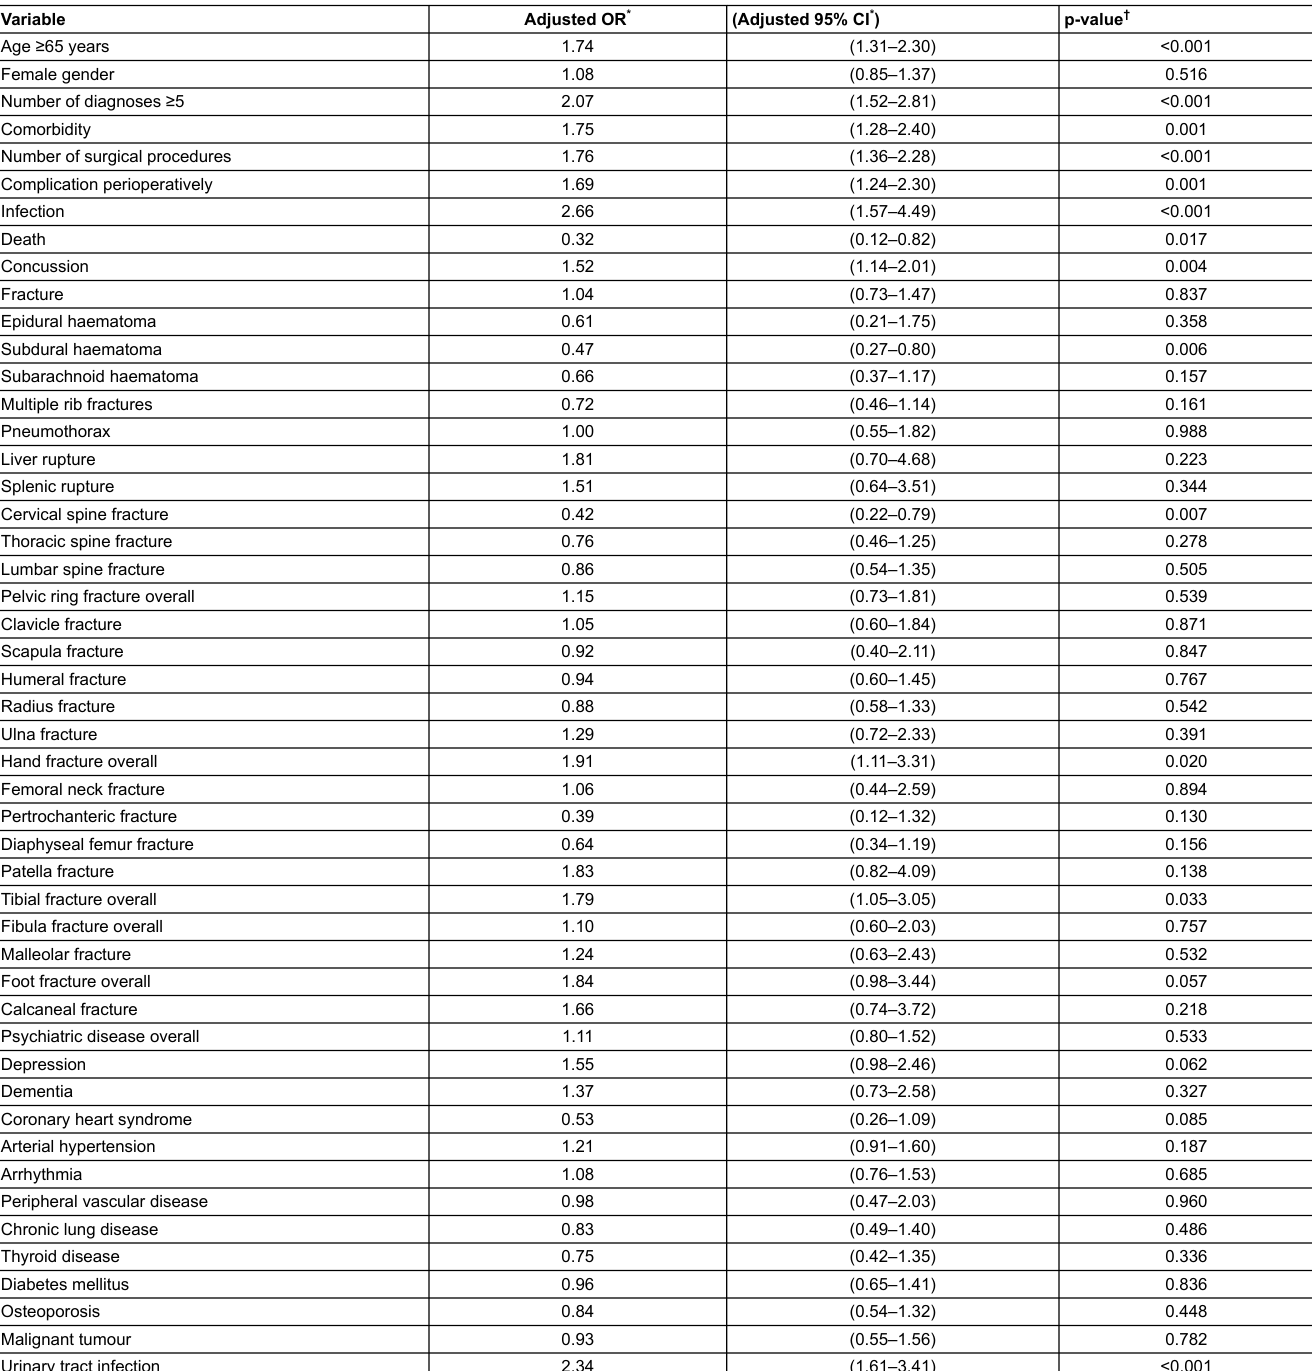
Table 6: Logistic regression model for factors associated with longer LOS outliers regarding length of hospital stay (LOS) (n =